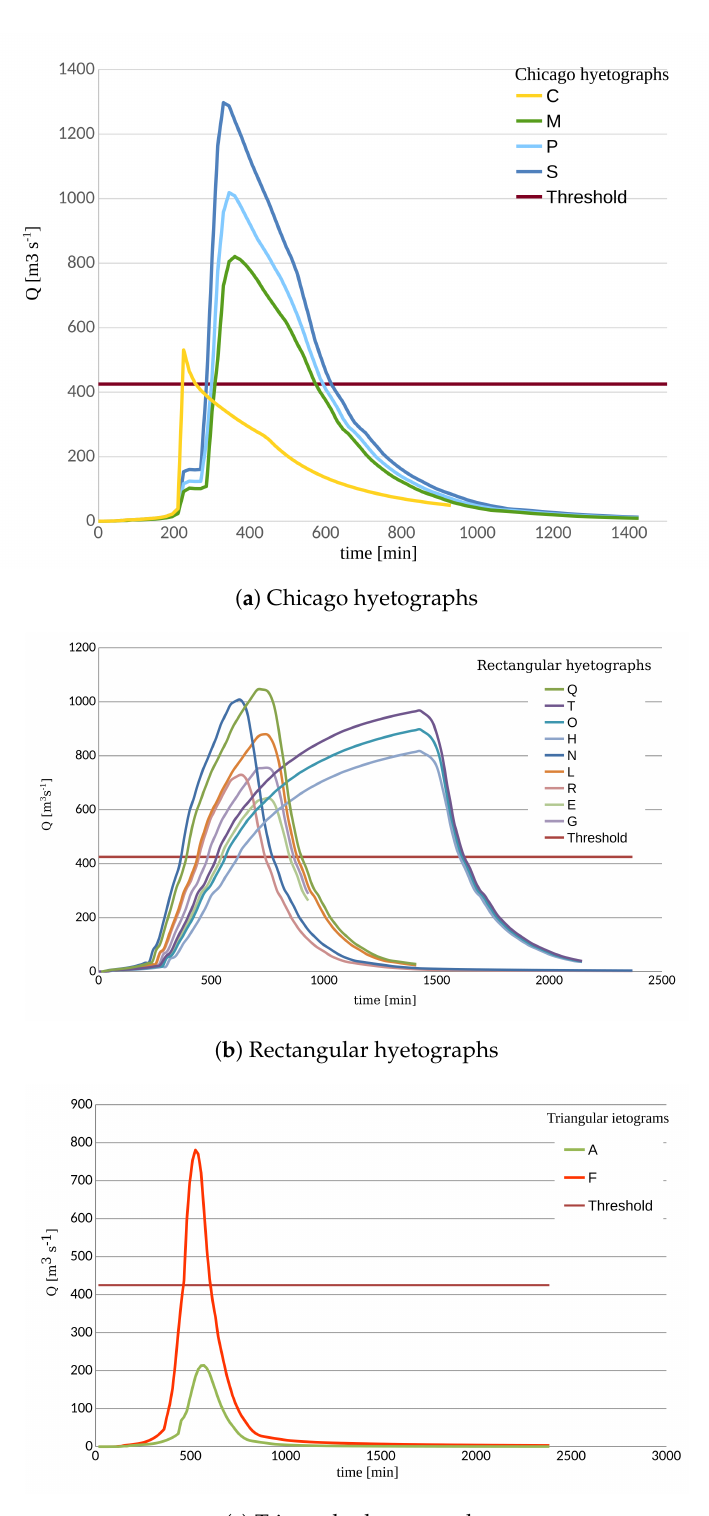
Figure 7. Hydrographs simulated by SWMM model in Corace watershed (Calabria, Italy) for n = 17 rainfall-runoff events, using as input ( a ) Chicago, ( b ) rectangular and ( c ) triangular